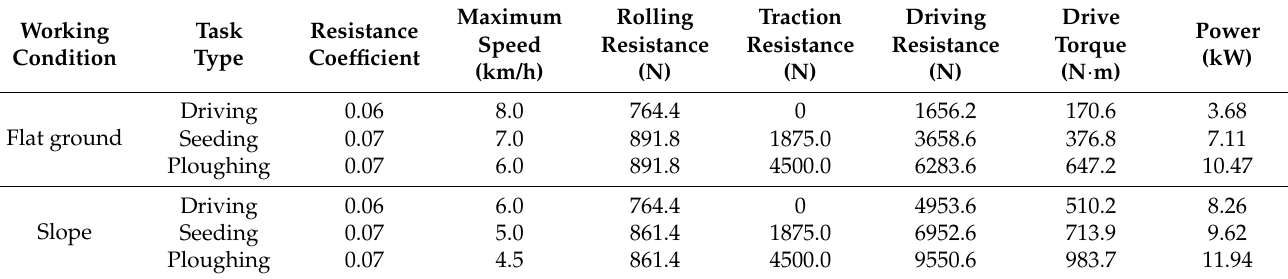
Table 3. Loads and power of the hillside crawler tractor under typical working